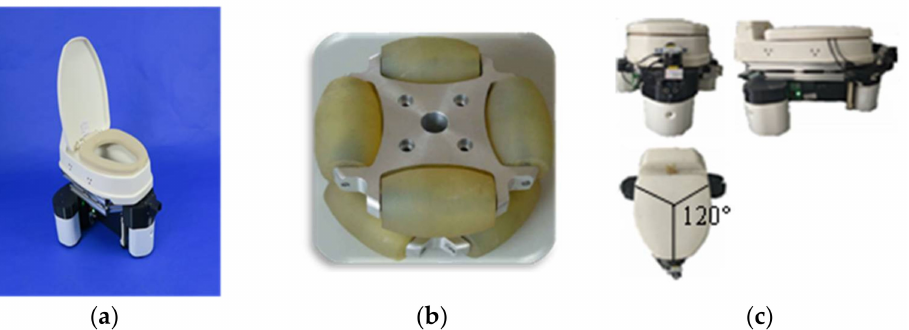
Figure 1. The mechanical structure of the ALR: ( a ) ALR; ( b ) Omni-directional wheels; ( c ) physical picture of the ALR.